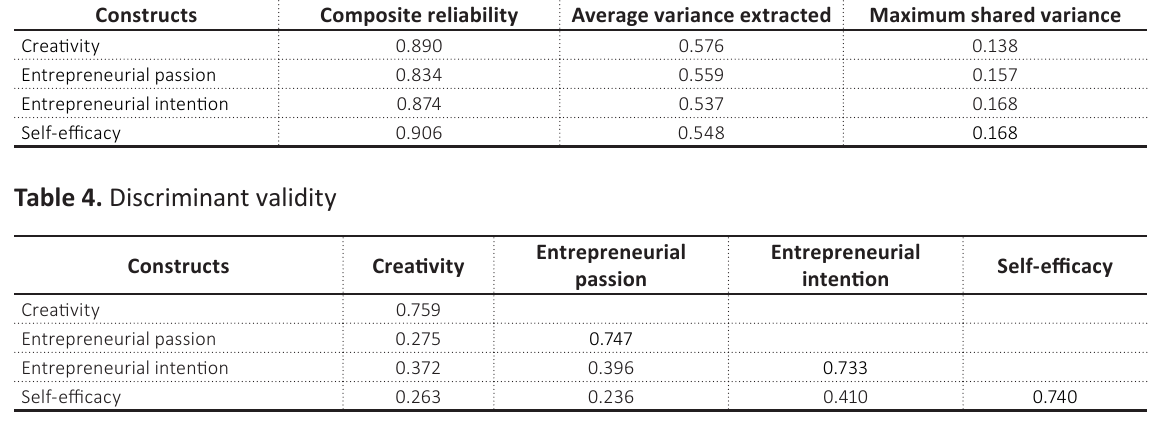
Table 3. Summary of a measurement model Constructs